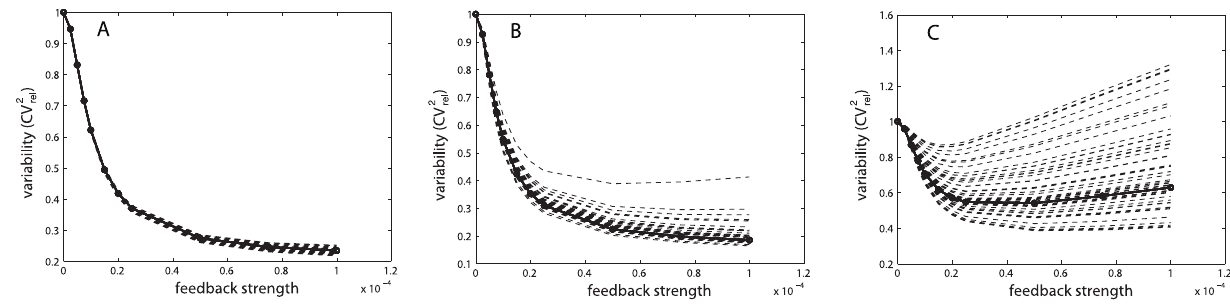
Figure 12. Small, medium and large differences in total protein variability resulting from different covariance matrices. Simulations of total variability resulting from 50 different random correlation matrices selected from 1000 runs for visual clarity (dashed line) and a diagonal correlation matrix (solid line). The total variability shows different degrees of sensitivity to correlation matrices, depending on parameter variances: (A) a 1 ~ 0 : 01 , a 2 ~ 0 : 2 , a 3 ~ 0 : 03 , a 4 ~ 0 : 01 (B) a 1 ~ 0 : 03 , a 2 ~ 0 : 01 , a 3 ~ 0 : 2 , a 4 ~ 0 : 2 (C) a 1 ~ 0 : 01 , a 2 ~ 0 : 03 , a 3 ~ 0 : 03 , a 4 ~ 0 : 03 .